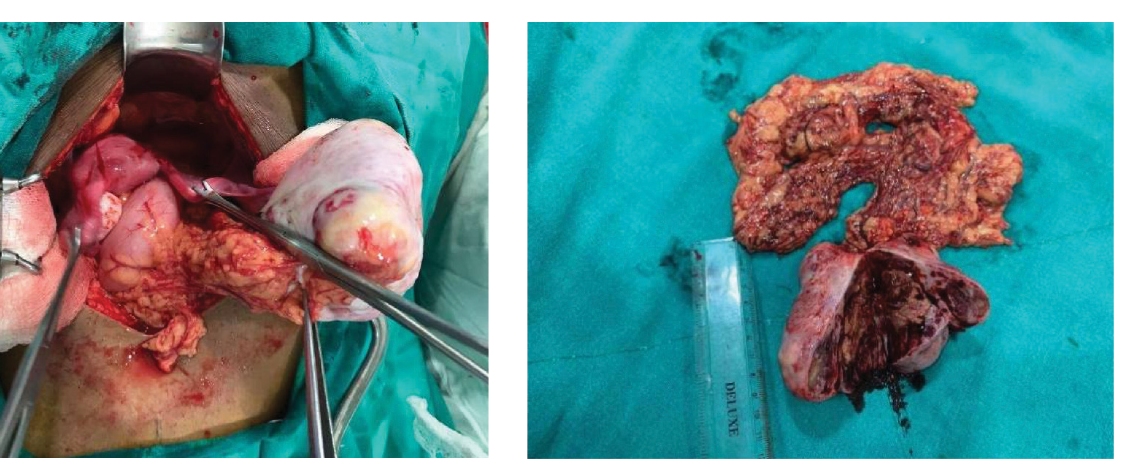
Figure 3B: Cross-section of Right Ovarian mass showing necrosis and hemorrhage with adjacent